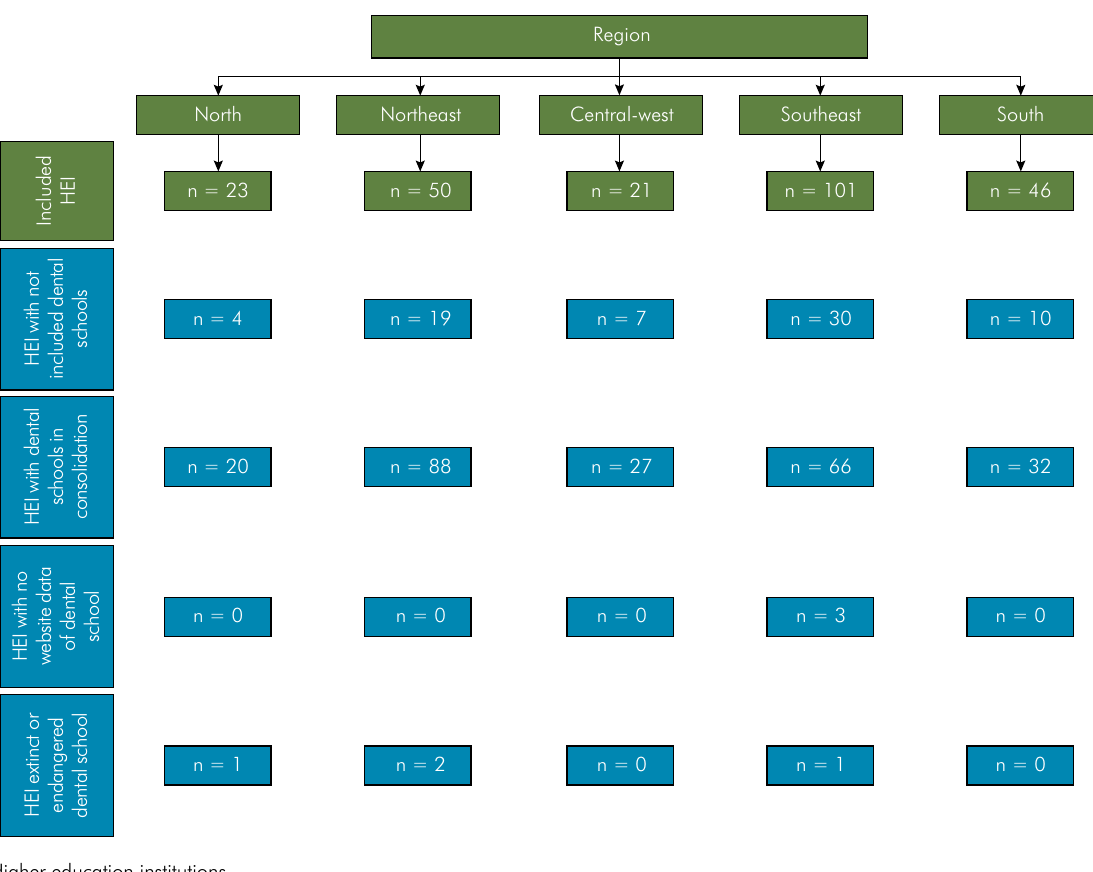
Figure 1. Distribution of dental schools in Brazil included and excluded of